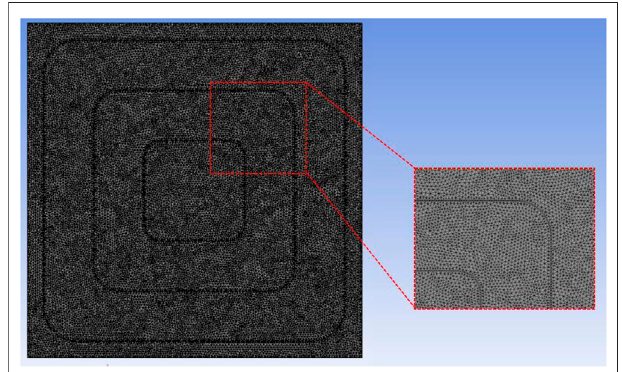
FIGURE 3 | Area divisions and grids of the surface of the heat